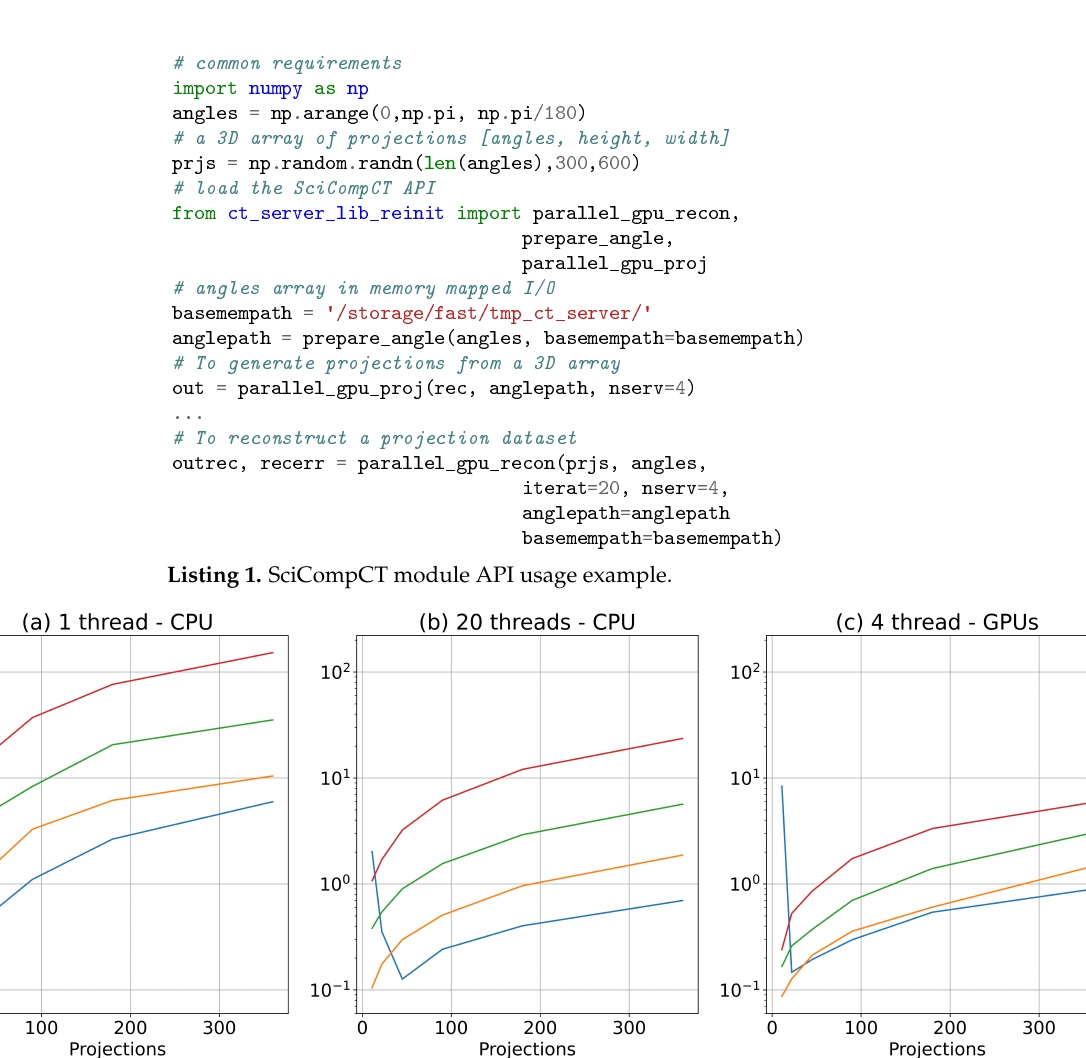
Figure 5. Performance comparison for the registration module, shown for single-thread (first column), 20 threads (center column) and a multi-GPU implementation (third column). The performance gain in terms of speed is large even for the CPU-only multi-threaded solution.